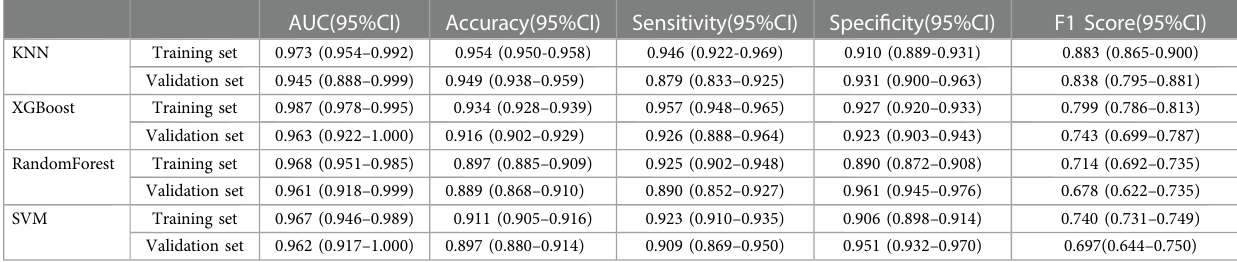
TABLE 2 Evaluation of the performance of the four